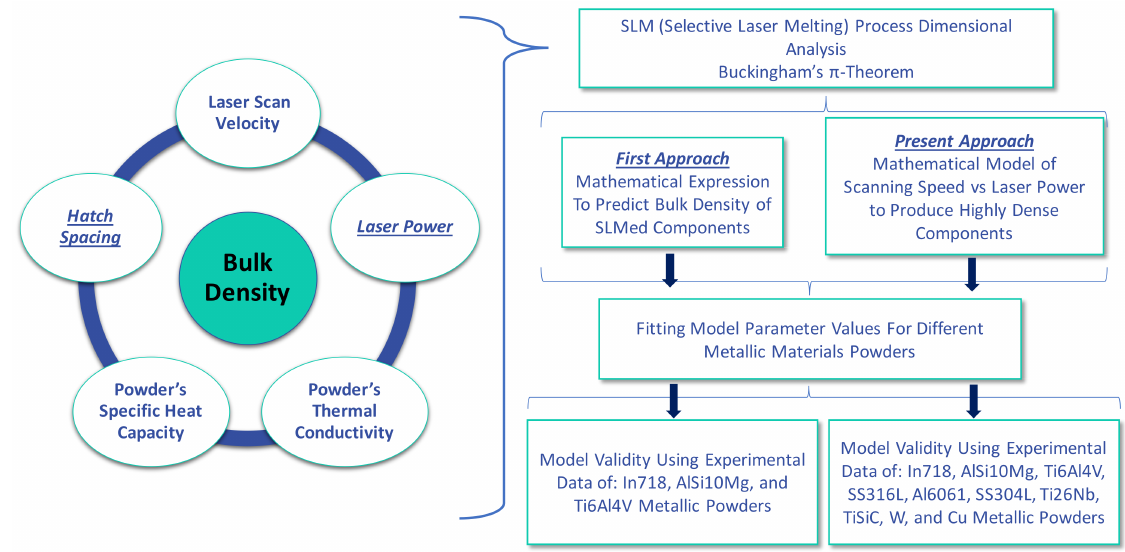
Figure 1. Schematic of the methodology followed throughout the present